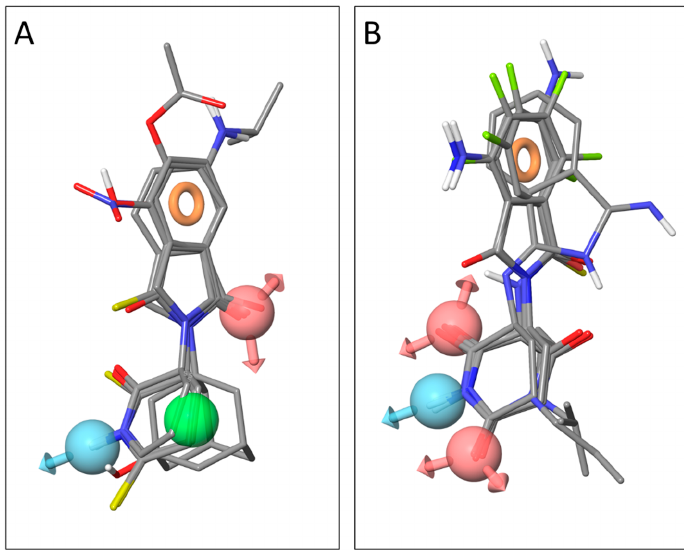
Figure 5. Pharmacophores for two calculated target binding modes. Acceptor site points are colored pink, donors are colored light blue, hydrophobic regions are green, and aromatic rings are orange circles. ( A ) A potential non-cereblon binding pharmacophore for compounds with hydrophobic rings. ( B ) A cereblon-binding pharmacophore for glutarimide-containing compounds.